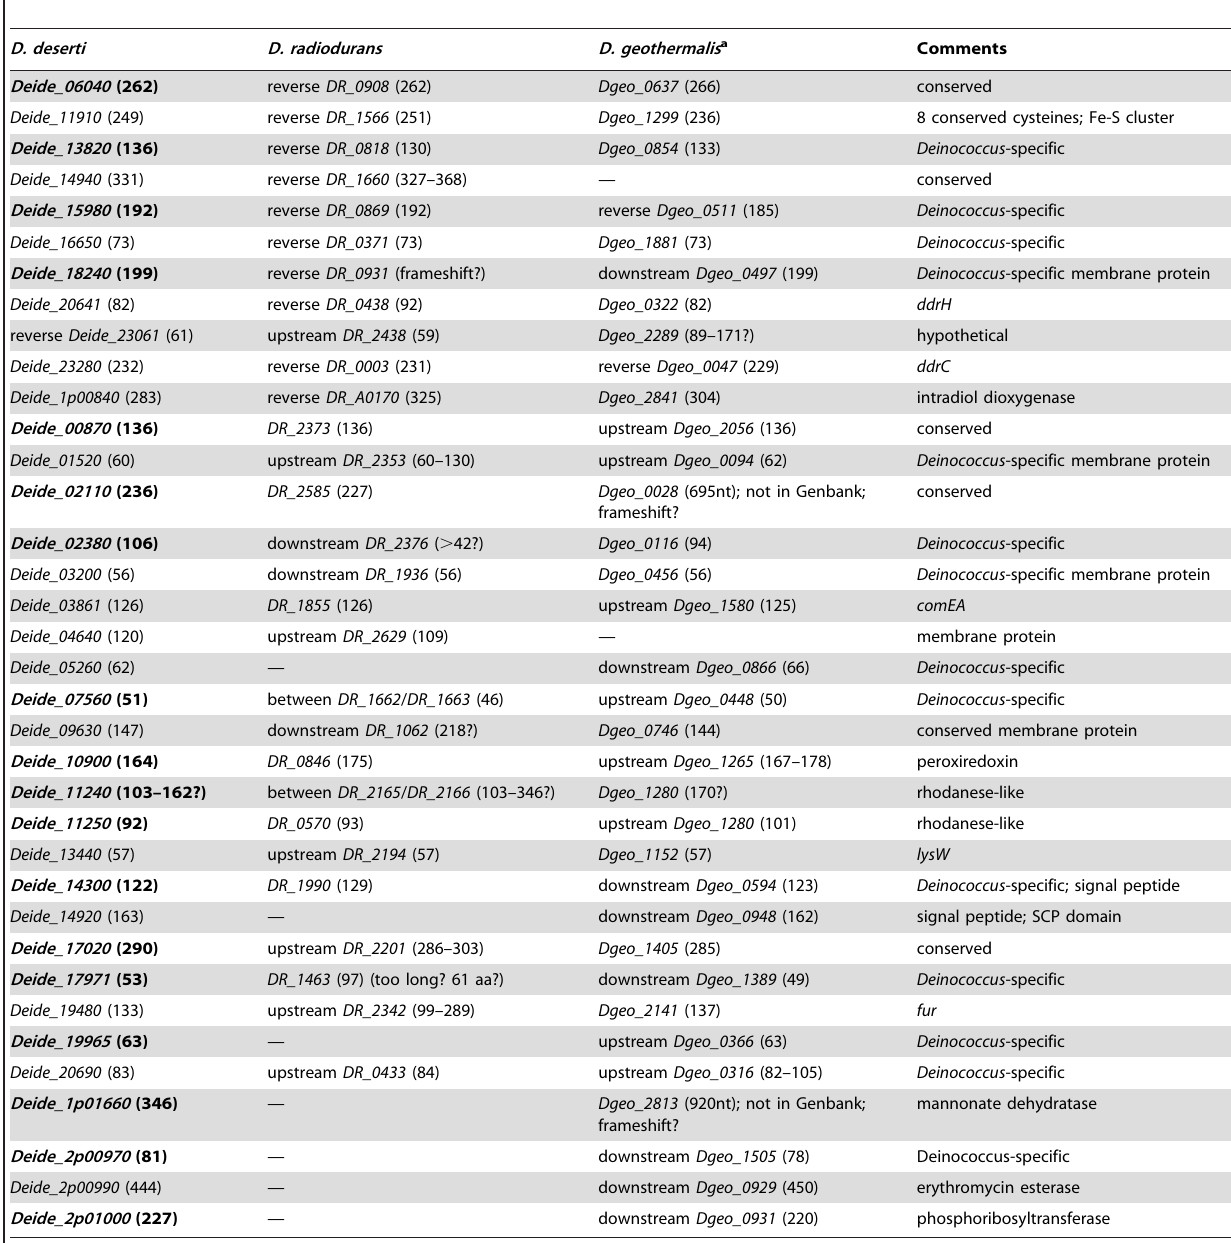
Table 2. Differently annotated conserved loci in D. deserti , D. radiodurans , and D. geothermalis